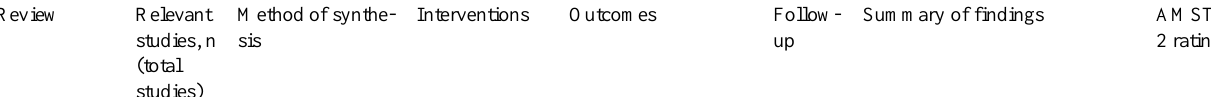
Table 7. Effectiveness of digital interventions on alcohol consumption, sorted by controls and further ordered by intervention